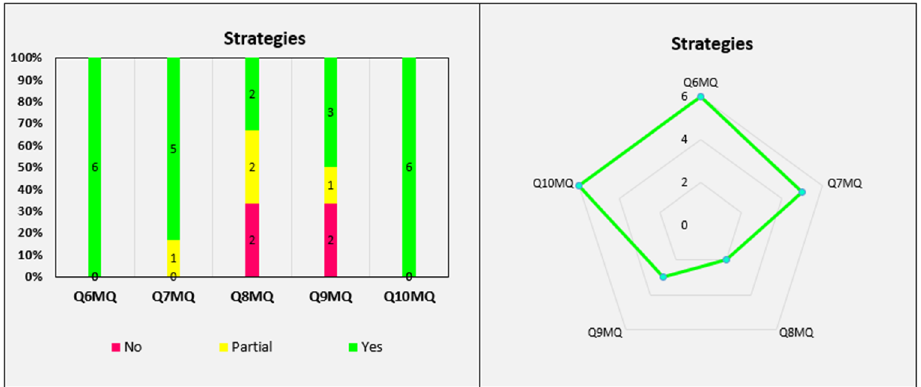
Figure 10. Answers regarding the strategy